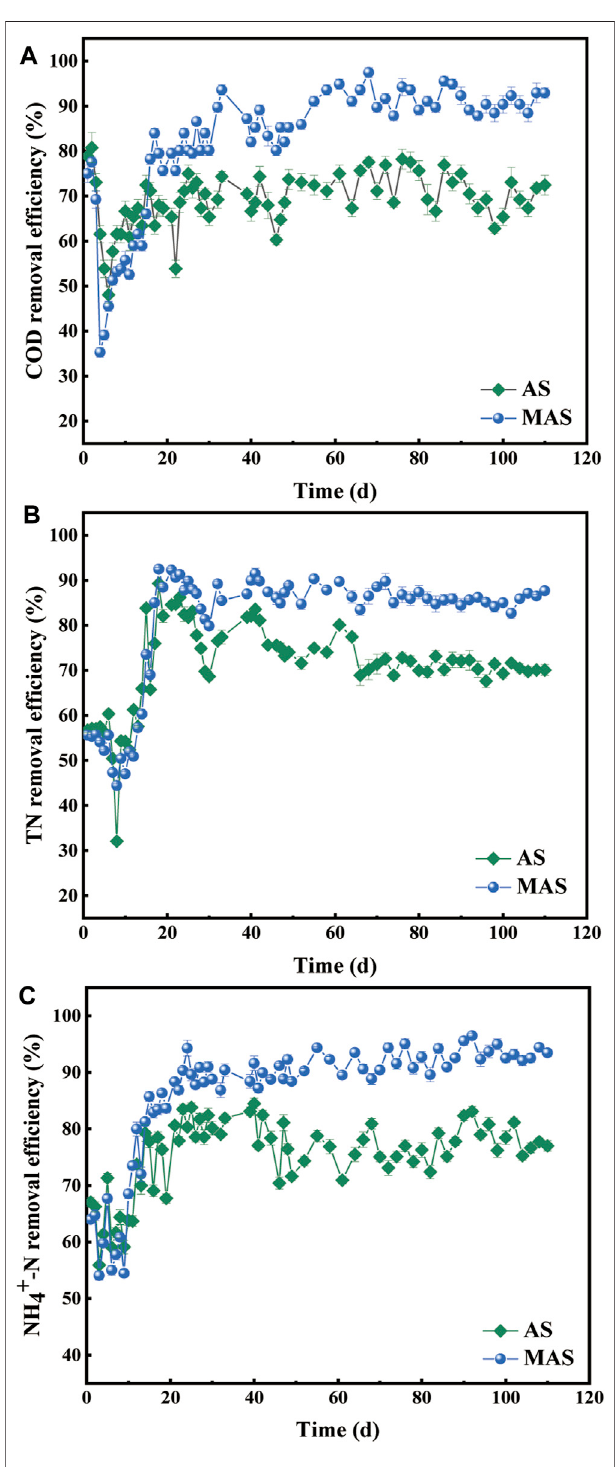
FIGURE 3 | Removal ef fi ciencies of (A) COD, (B) TN, and (C) NH 4 + -N with MAS and AS reactors.